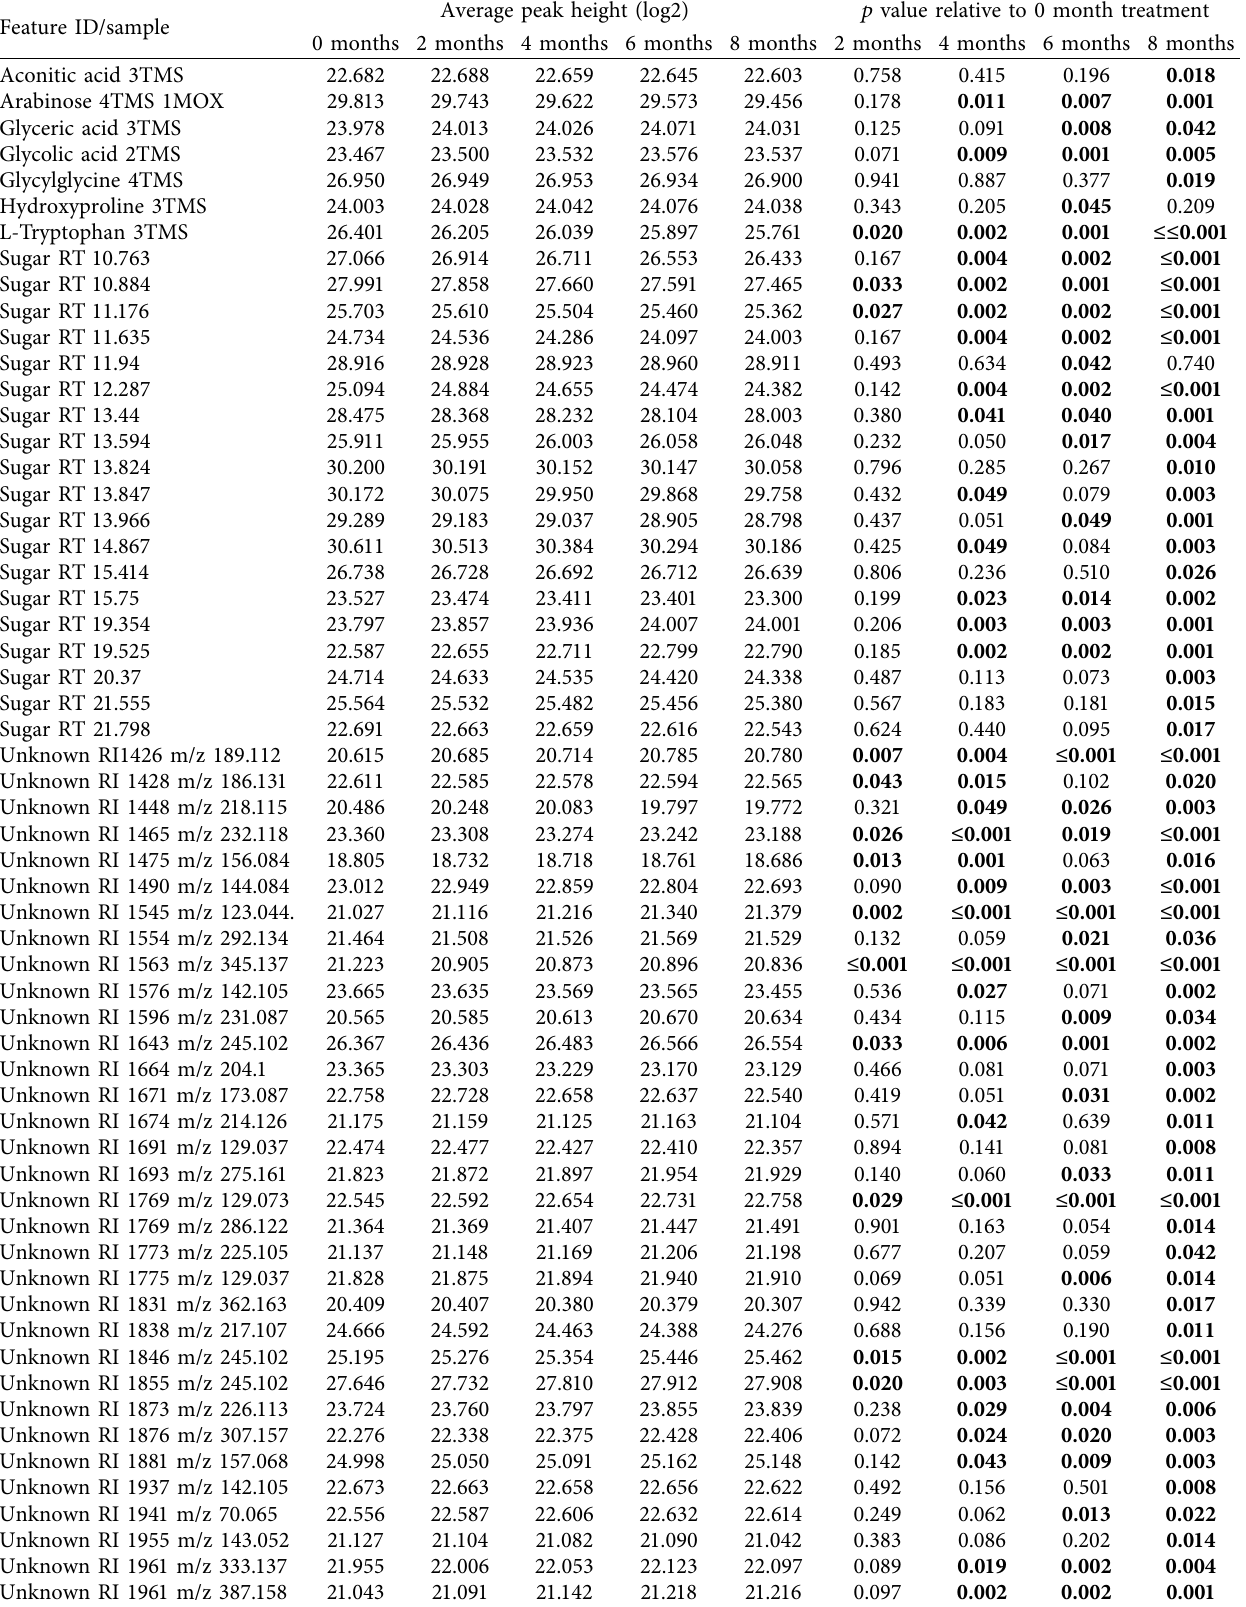
Table 3: Average peak heights (log 2 converted) of analytes resolved from aged soy sauce samples selected on the basis that their relative concentrations changed as a result of aging.